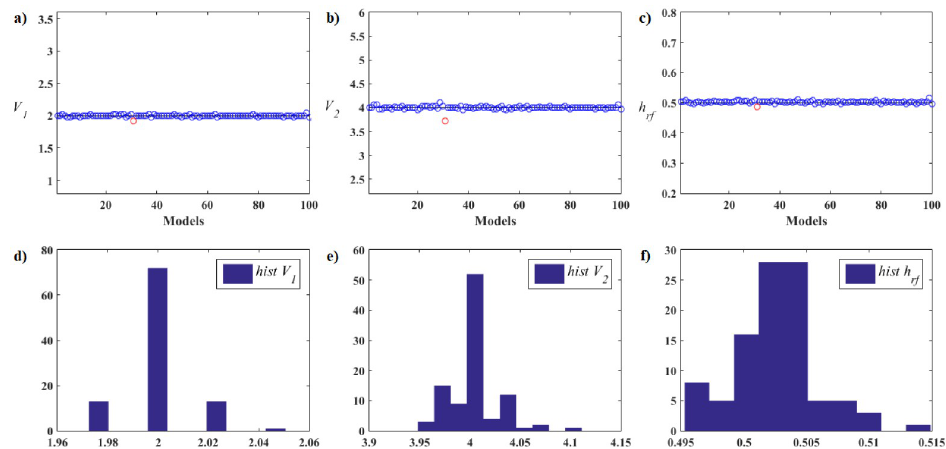
Fig 21. Case 1 (100 × 20). (a), (b), and (c) are all results obtained by the PSO mod algorithm for variables V 1 , V 2 , and h rf , respectively. (d), (e), and (f) are their respective histograms.